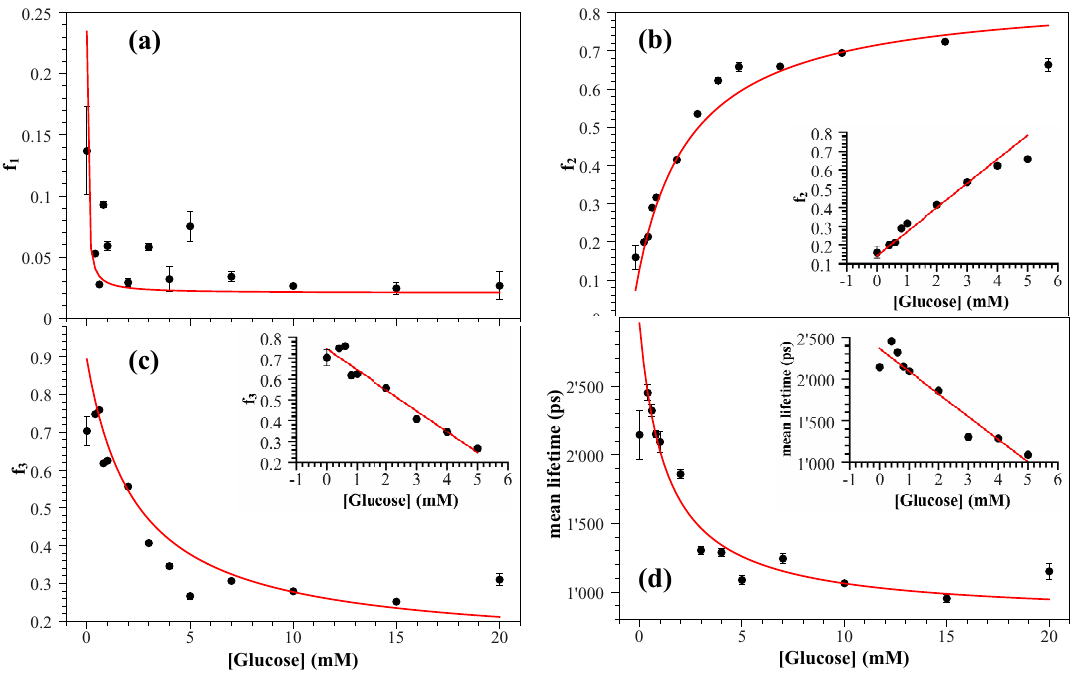
Figure 9. The fluorescence fractional components f retrieved from the three-exponential i fitting and the mean lifetime (cid:22) (cid:28) as a function of the glucose concentration. Red curves represents the fit of data with the Michaelis–Menten like expression (4). Insets in panels b,c,d show the glucose calibration curves for each